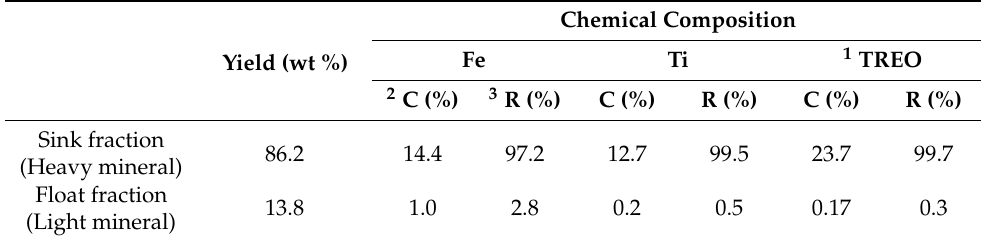
Table 3. Sink-float experiment results of feed